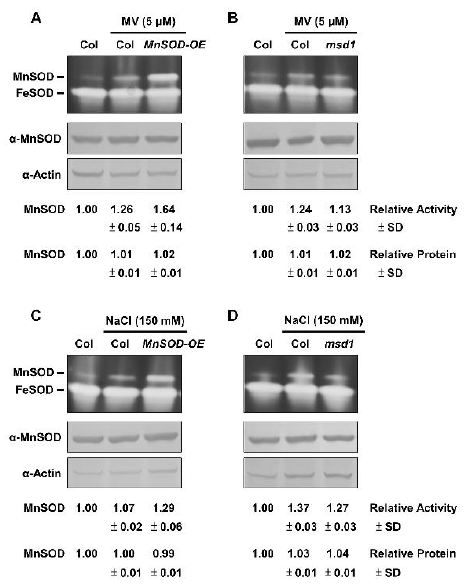
Figure 3. MnSOD activity and protein levels of MnSOD-OE and msd1 seedlings in response to oxidative stressors. Fourteen-day-old seedlings were incubated with 5 µ M MV ( A , B ) or 150 mM NaCl ( C , D ) for 24 h, as indicated. In-gel SOD activity assay ( top ) and immunoblotting with α -MnSOD and α -Actin antibodies ( bottom ) were conducted. Actin was used as a loading control. MnSOD activity and protein levels were measured relative to those in Col control. Data represent one of three independent repeats.